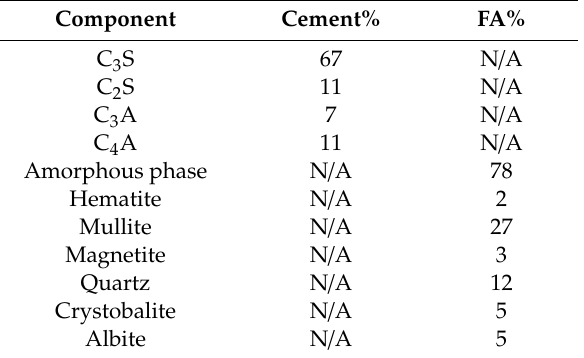
Table 2. Crystalline composition compositions of materials used.